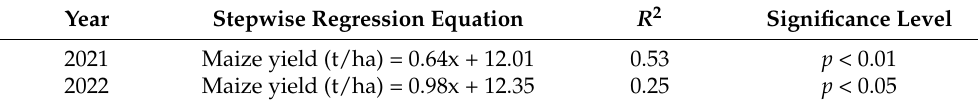
Table 6. Regression analysis of integrated fertility scores with maize